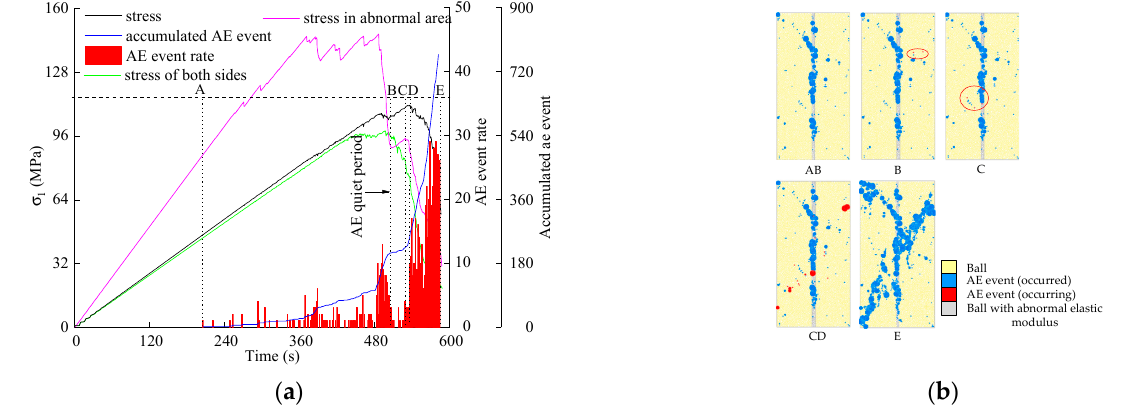
Figure 5. Numerical simulation results. ( a ) Stress and AE events of specimens with abnormal elastic modulus of 40 GPa; ( b ) AE events distribution at different stages of the specimen.